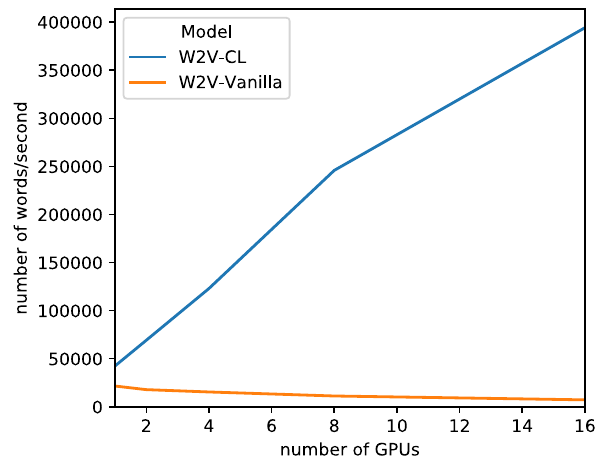
Fig. 21 Training speed of CNN-based subword-level word embed- dings with different number of